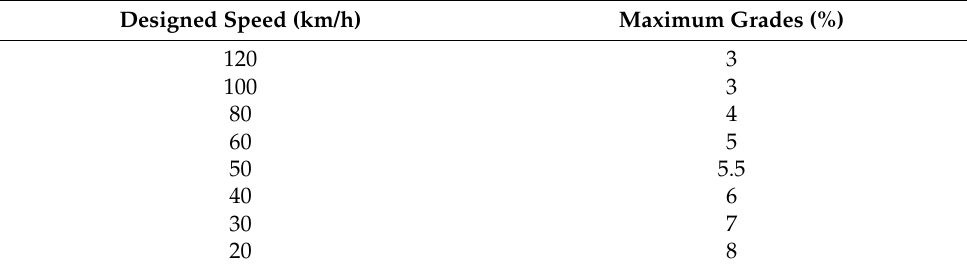
Table 2. Maximum grades for types of roads in JTG 2112–2021. Designed Speed